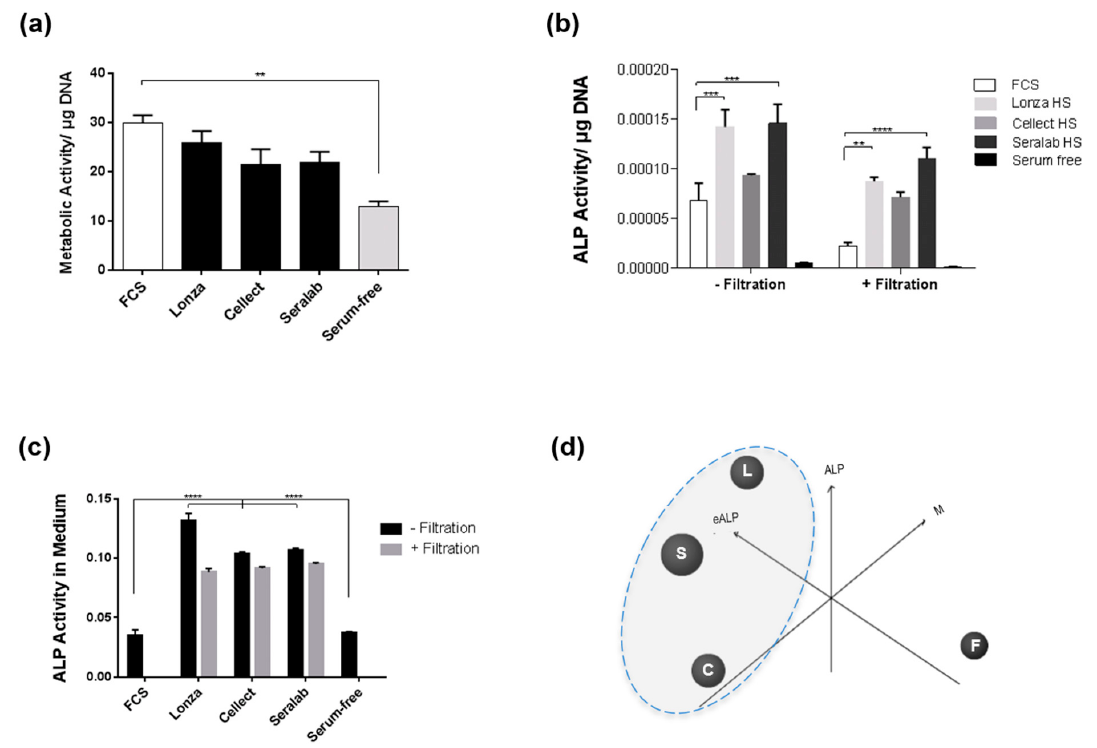
Figure 2. MSC culture using di ff erent serum products. ( a ) Metabolic activity in MSCs cultured for five days in SC culture media containing FCS or HS from Lonza, Cellect Seralab, or no serum (serum-free) as controls. ( b ) Alkaline Phosphatase activity for MSCs cultured for five days in SC medium supplemented with FCS or HS sera. ( c ) Alkaline Phosphatase activity measured in the di ff erent culture media in the absence of cells. * p < 0.05, ** p < 0.005, *** p < 0.0005, and **** p < 0.00005 ( n = 6). ( d ) 3D plot of cell metabolic assay (M), cell ALP assay (ALP) and endogenous ALP assay (eALP) results for di ff erent sera showing clustering of Lonza HS (L), Seralab HS (S) and Cellect HS (C) away from FCS (F).